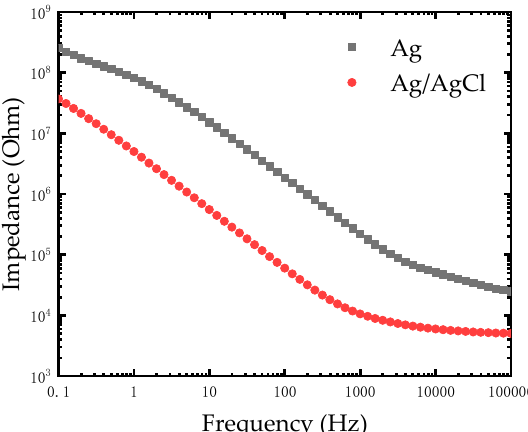
Figure 5. Impedance comparison diagram of the Ag electrode and modified Ag / AgCl electrode in phosphate buffered saline (PBS) solution. Table 1. The impedances of the Ag electrode and modified Ag / AgCl electrode at di ff erent